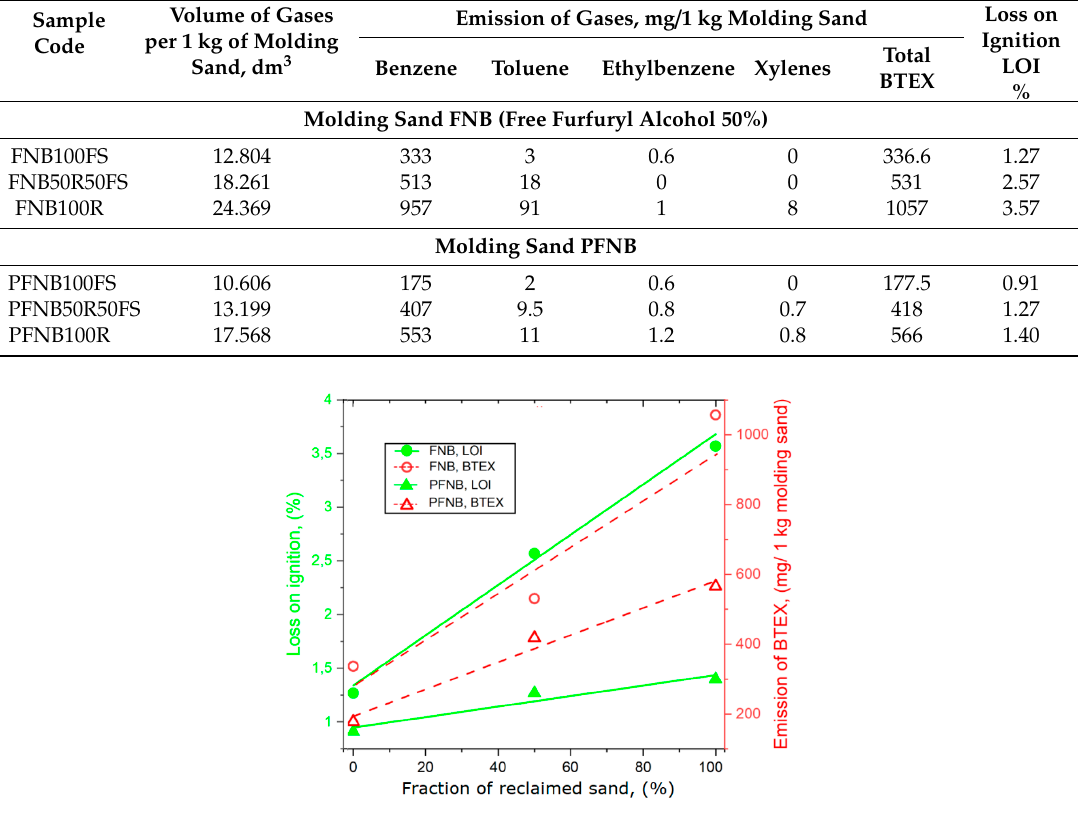
Figure 3. The dependence of emission of BTEX on the LOI of the given molding sand with reclaimed sand fraction [32,33]. Table 7. Quantity of PAHs released from FNB and PFNB during thermal decomposition of molding sand with reclaimed sands